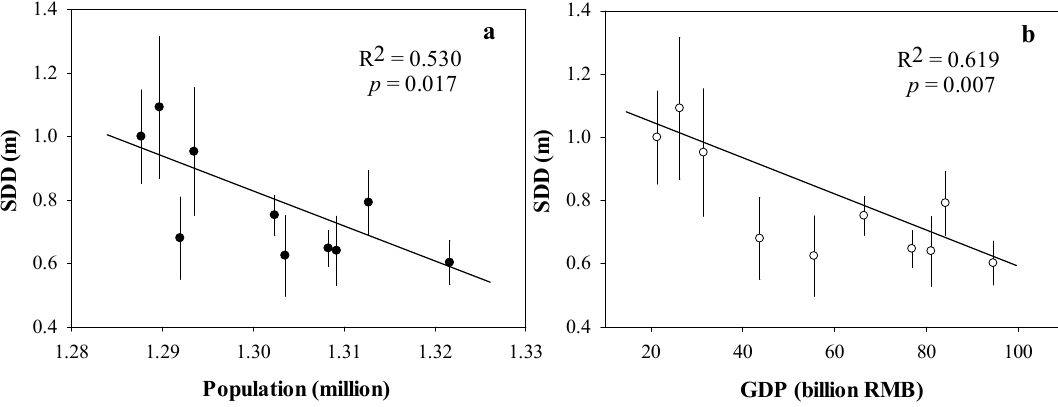
Figure 8. Correlations of the SDD with ( a ) population and ( b ) GDP. Error bars represent SDD standard deviations.